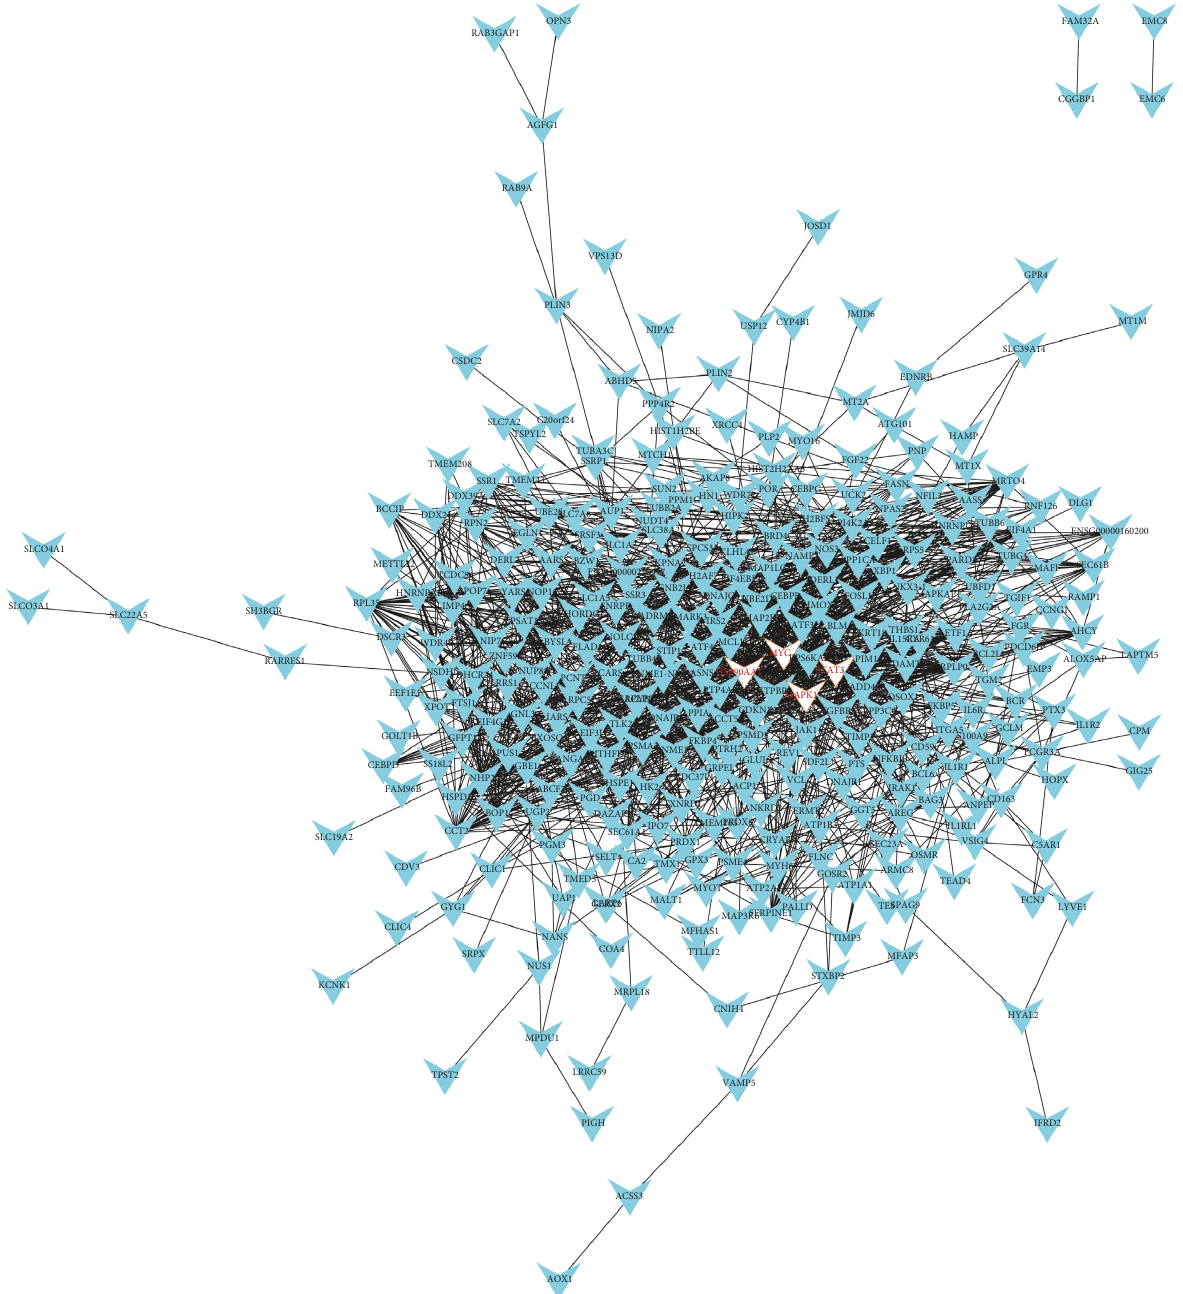
Figure 5: PPI network of downregulated DEGs. Nodes represent genes, and edges represent the connectivity between genes, and the red node represents the hub genes, including 325 nodes and 1495